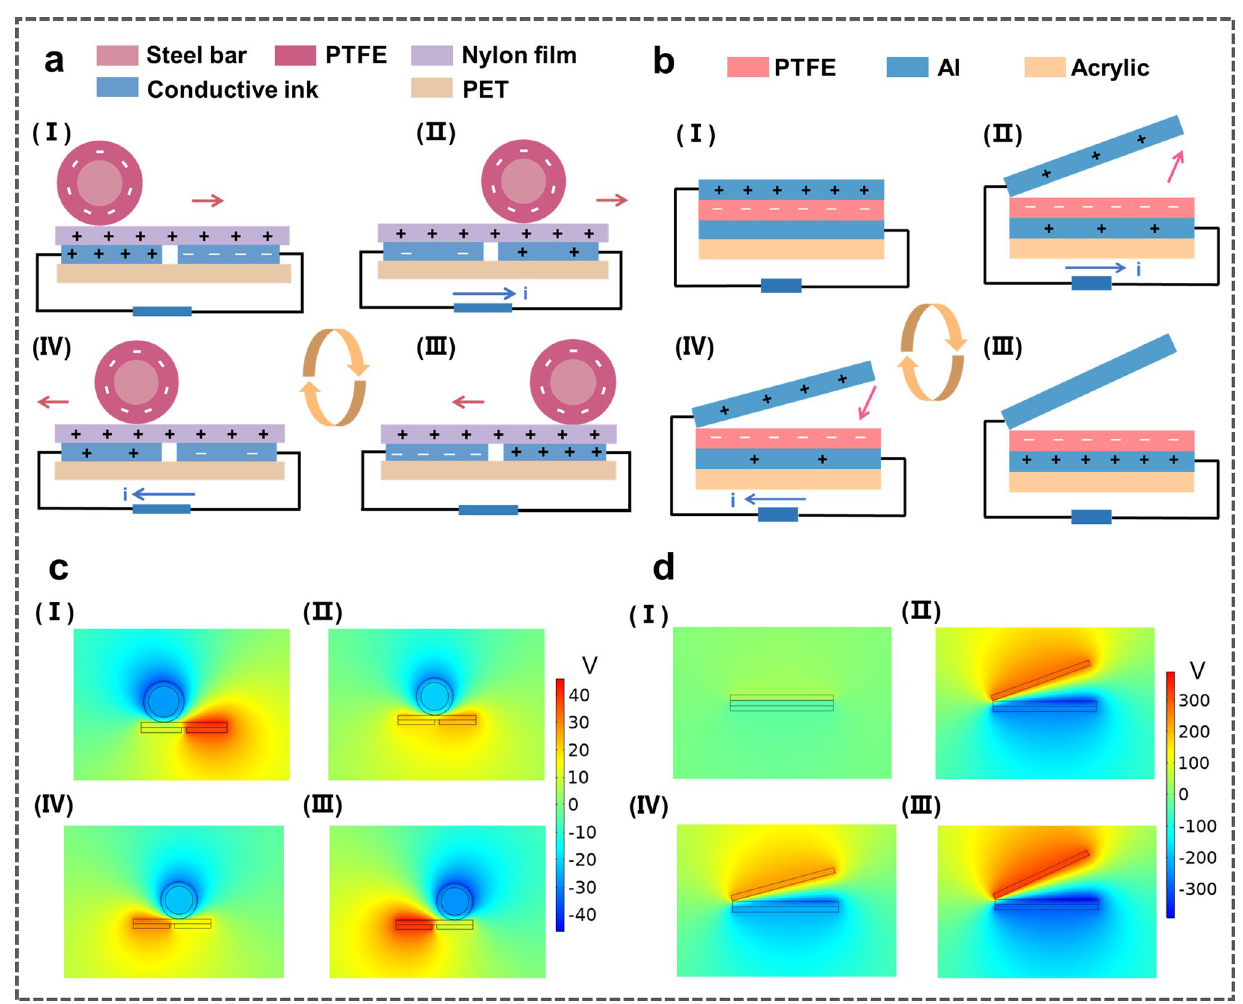
Fig. 2 Working principles of the EC-TENG. a, b Sketches of the working principles of a the internal part and b the external part. c, d The cor- responding potential distributions of the c inner TENG and d outer TENG calculated by COMSOL in a two-dimensional plane